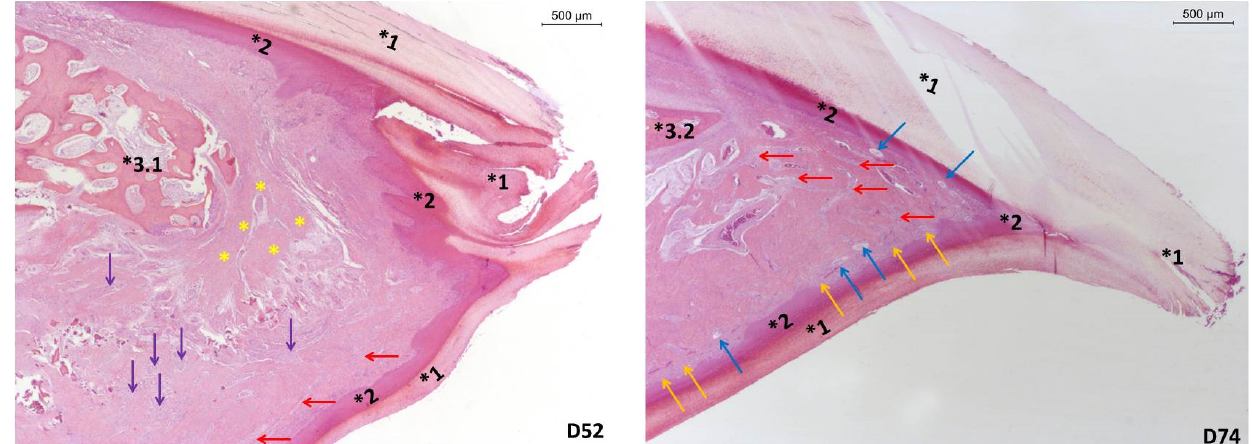
Figure 3. Histological examination of the upper beak tip after Phase 6 (138 DOL), 25× magnification and stained with hematoxylin-eosin. On the left side (D52) an infrared-trimmed beak tip and on the right side (D74) a beak tip of a turkey with integrated screed grinding wheel. *1 = keratin sheath (rhamphoteca); *2 = epidermis; *3.1 = blunted praemaxillary bone; *3.2 = praemaxillary bone; yellow asterisks = connective tissue in the form of scar tissue; purple arrows = disordered smaller nodes of nerve tissue; red arrows = nerve fibers; blue arrows = Herbst corpuscles; orange arrows = Grandry corpuscles.